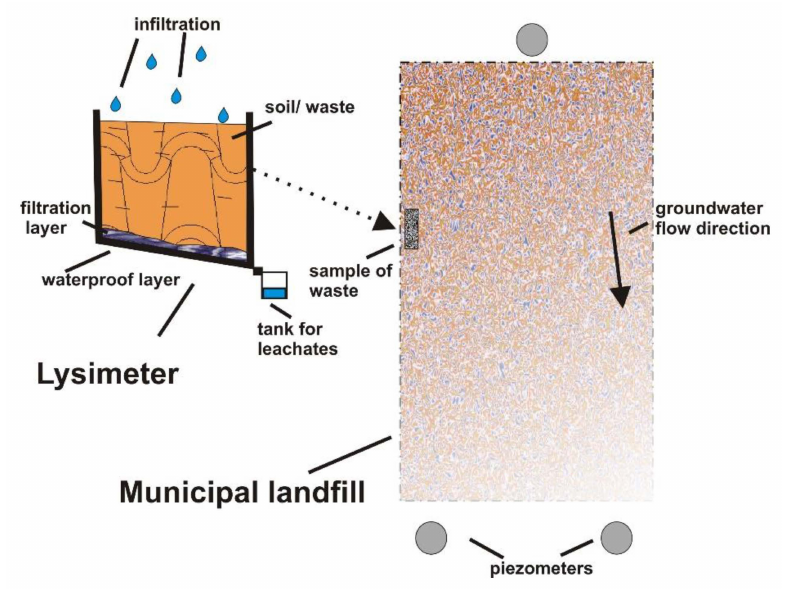
Figure 1. General sketch of the